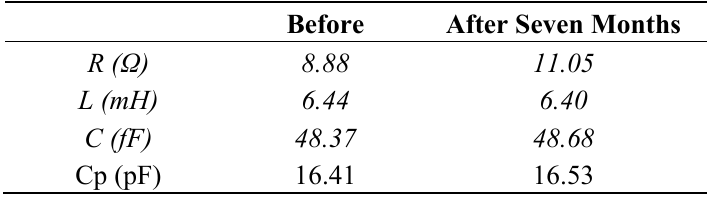
Table 2. Comparison between the EQC parameters of QCM sensor before beginning the trials in battery and after seven months immersed inside the battery’s electrolyte. Measurements in